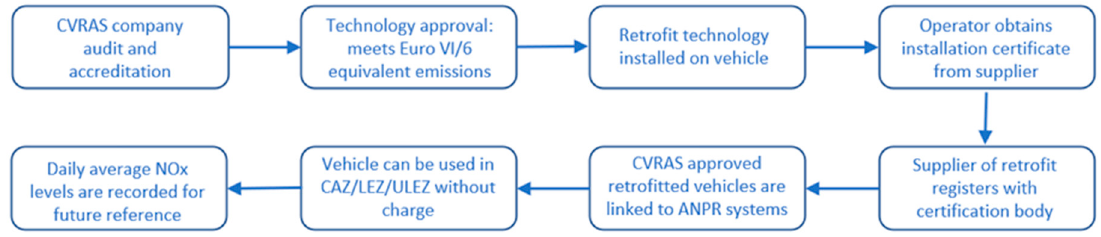
Figure 11. CVRAS process diagram, redrawn from [96].